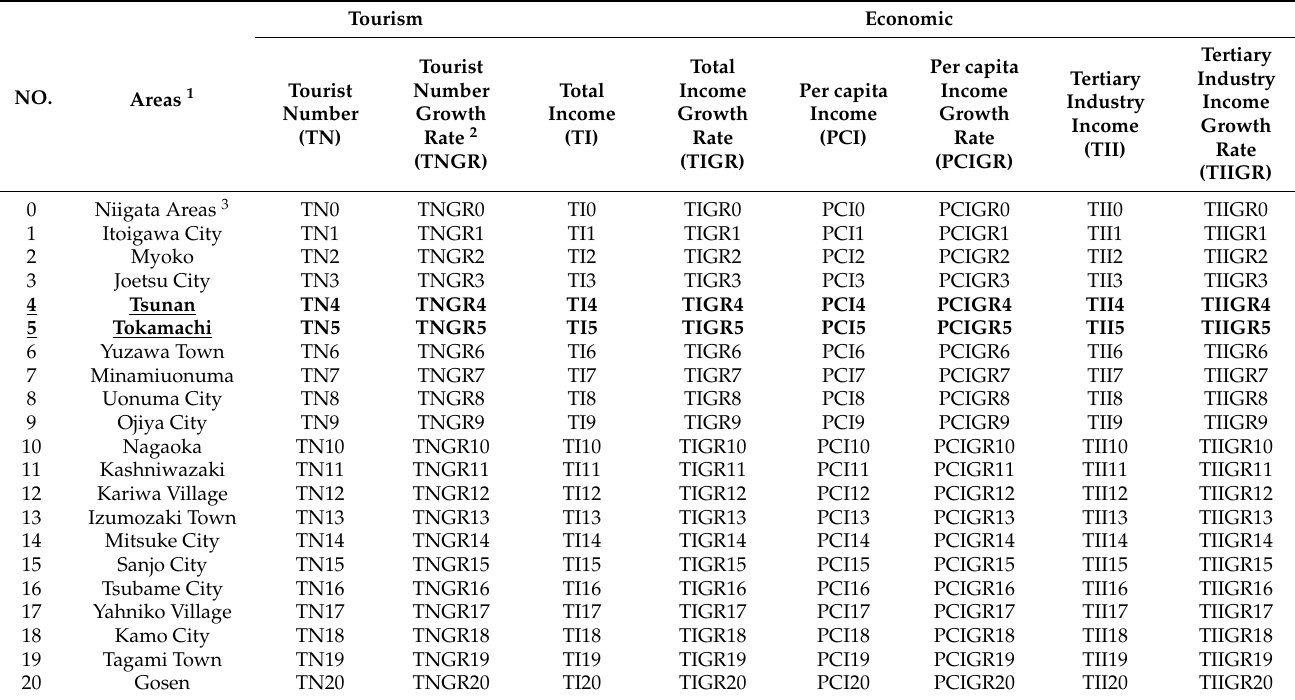
Table 2. Continuous variables